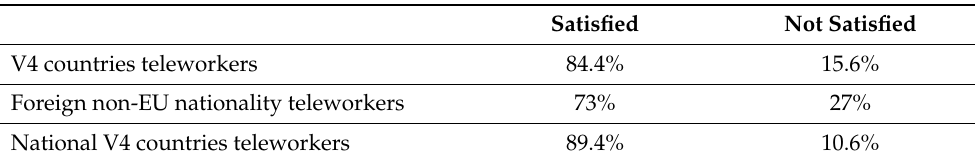
Table 2. V4 countries teleworkers’ satisfaction with working from home experience during COVID-19 lockdown; foreign non-EU citizens vs.